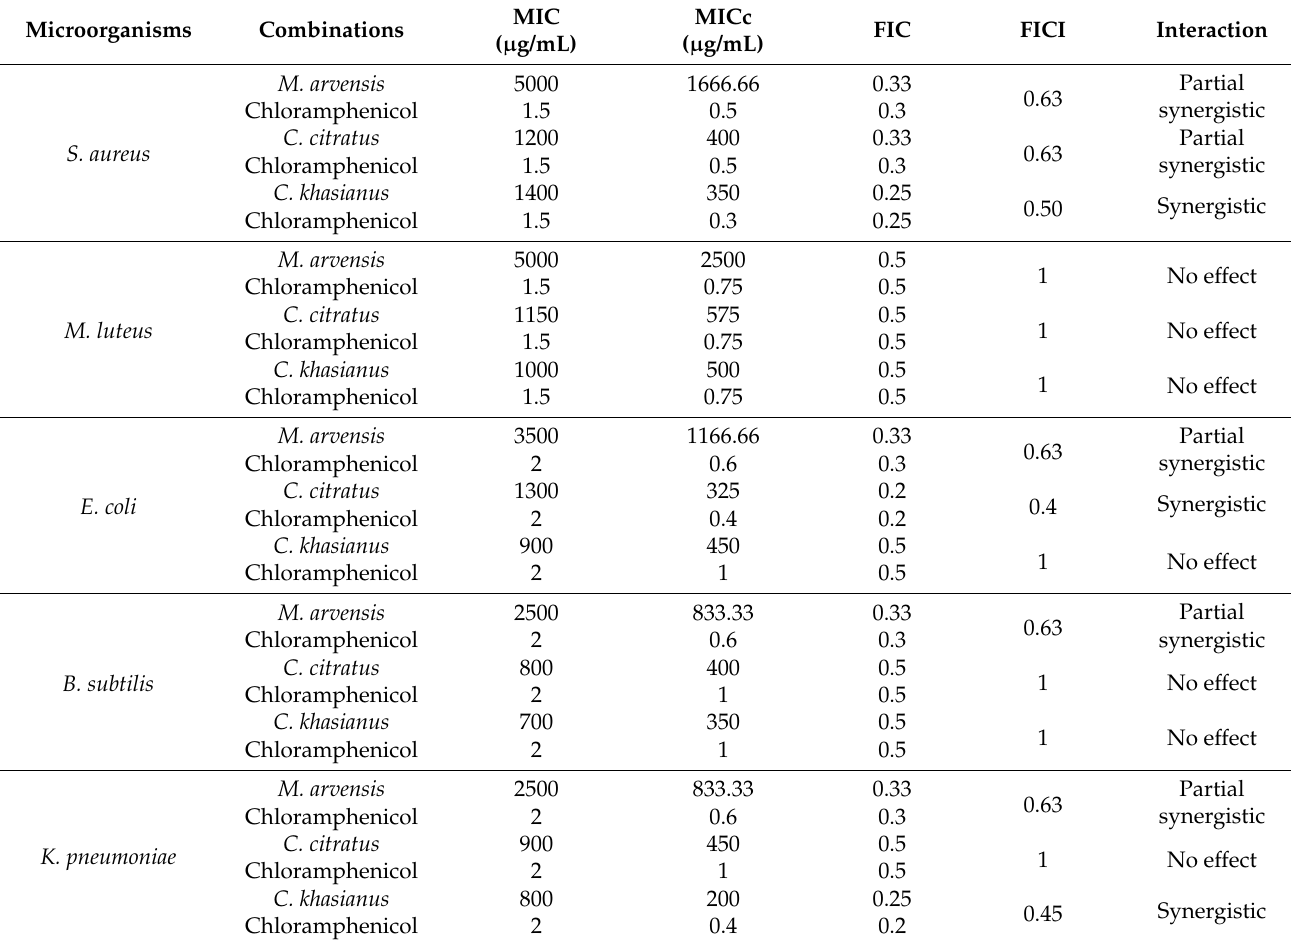
Table 3. Effect of combinations between essential oils and chloramphenicol.